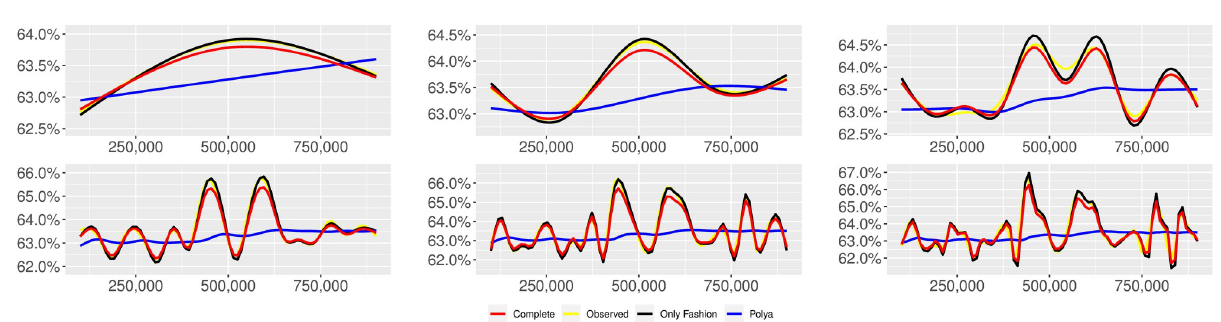
Fig 19. “10 days of traffic” ( T = 0.35, entire, D = 30 00 , slots = days): Sentiment curves. In each panel, the yellow line is the cubic spline smoothing of the time series of the observed tweets ξ n +1 , together with the default confidence interval (gray), the red line represents the cubic spline smoothing of the time series of the estimated predictive means ^ c (defined in Subsec. 3.2), obtained with the complete RP model, the black and the blue lines provide n similar approximations obtained with the other models: black = Only fashion RP model and blue = Standard Po´lya model. In each panel, the smoothing is obtained with a given number of nodes: k = 3 (top left panel), 5 (top middle panel), 10 (top right panel), 20 (bottom left panel), 30 (bottom middle panel), 50 (bottom right panel).